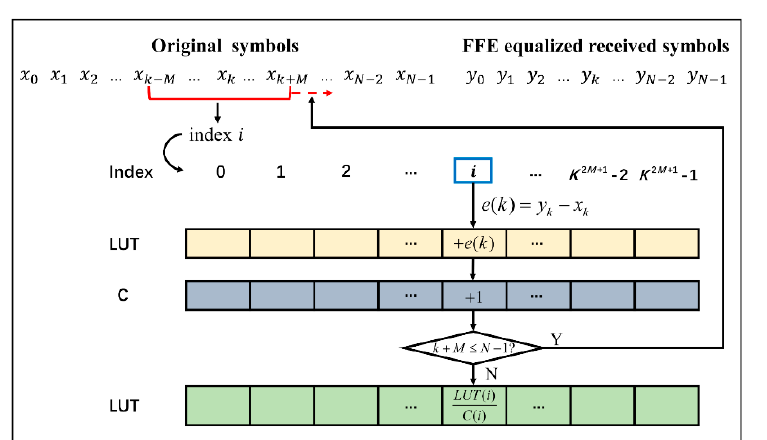
Figure 1. Process of LUT generation.